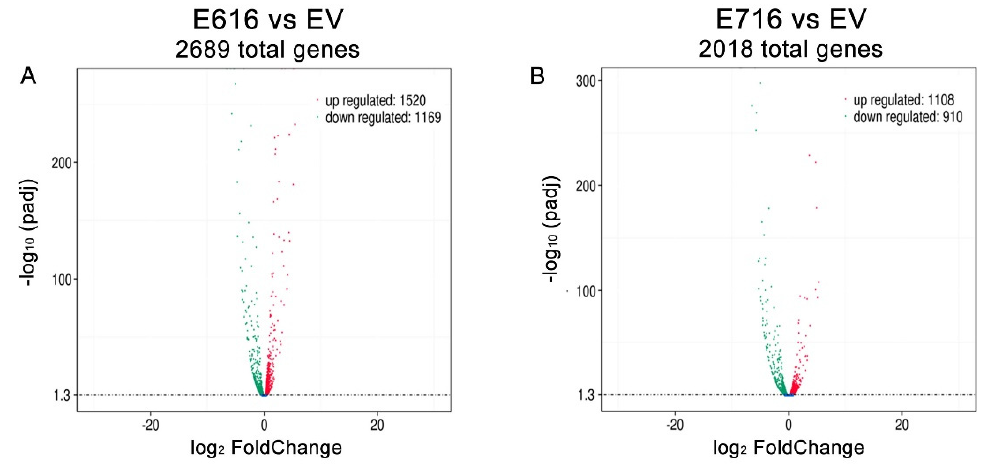
Figure 3. E616 and E716 differentially affected gene expression in C-33 A cells. Volcano plot illustrating the genes that were significantly ( p -adj < 0.05) deregulated in: ( A ) C33-E616 cells and ( B ) C33-E716 cells, compared with the EV control. The upregulated genes are depicted in red color and the downregulated ones in green.